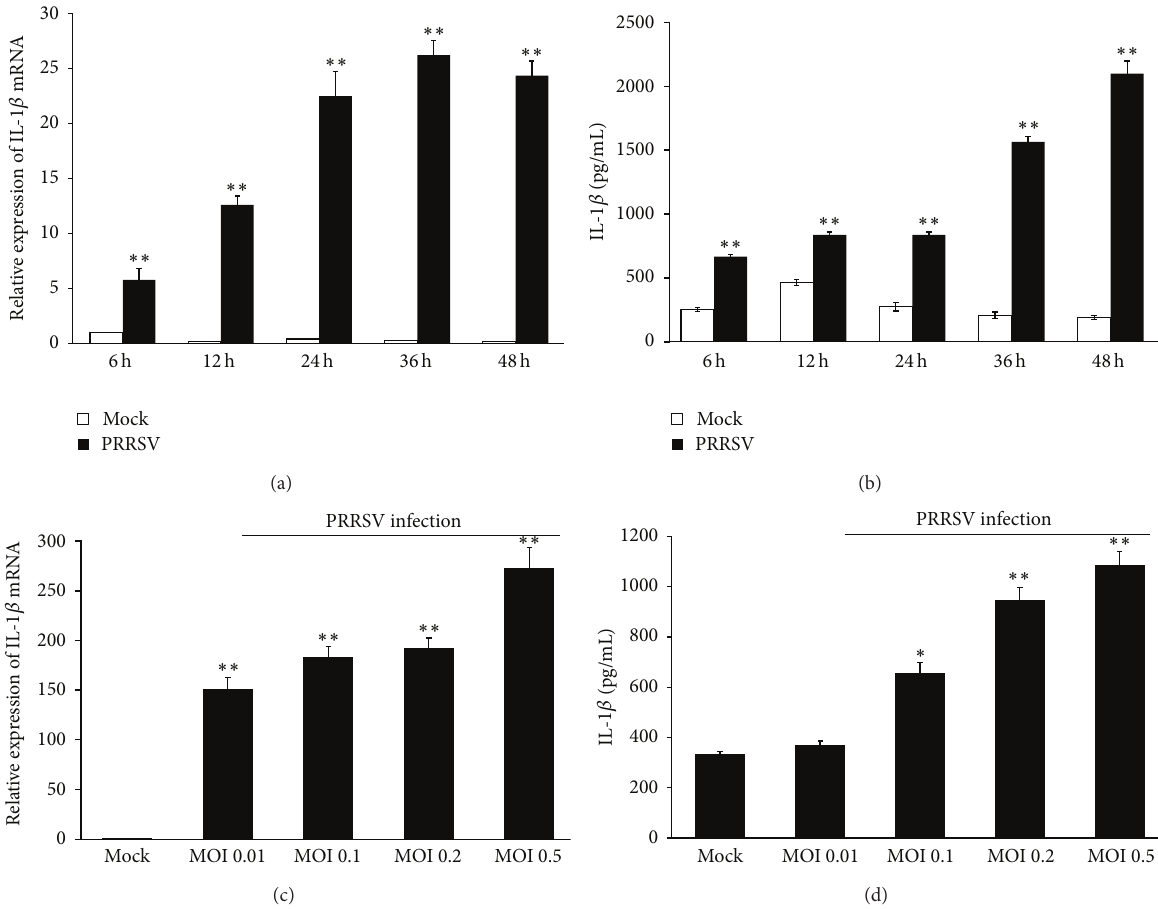
Figure 2: PRRSV infection increases IL-1 𝛽 mRNA expression and secretion in PAMs. (a, b) PAMs were mock infected or infected with PRRSV at a MOI of 0.1. Cells and supernatants were collected separately at the indicated time points and subjected to real-time RT-PCR (a) and ELISA (b) to analyze the expression of IL-1 𝛽 . (c, d) PAMs were infected with PRRSV at different doses (0.01, 0.1, 0.2, and 0.5 MOI). Cells and supernatants were collected separately at 36 h postinfection for analysis by IL-1 𝛽 -specific real-time RT-PCR (c) and ELISA (d). The mock-infected cells were used as negative controls. ∗ 𝑃 < 0.05 and ∗∗ 𝑃 < 0.01 compared with the mock-infected